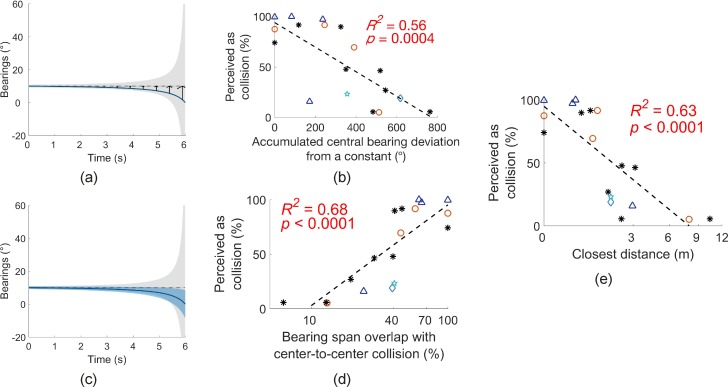
Visual cues for possible collision with an approaching pedestrian and their relationships with the collision judgment by the subjects. (a) Accumulated bearing deviations of pedestrian's central bearing from a constant bearing. The straight dashed gray line shows the constant central bearing representing the bearing of a center-to-center colliding pedestrian. The gray area indicates the bearing span of that colliding pedestrian increasing as a function of time. The dark blue curve shows the central bearing of a pedestrian passing-in-front, which starts at the same initial bearing. The black vertical arrows are samples of the accumulated bearing deviations. (b) The accumulated bearing deviations show a negative correlation with the subjects' perceived collision. (c) The bearing span overlap of the dark blue pedestrian (from (a)) with the center-to-center colliding pedestrian. The percent of overlap was calculated as the blue-gray overlapping area divided by the gray area. (d) The subjects' collision judgment shows a positive correlation with the bearing span overlap. (e) The collision judgment is negatively correlated with the closest distance between the subject and pedestrian. Data in the scatterplots are from the NV condition (same colors and icons as in Fig. 7). Additional data (black asterisks) are from (Qiu C, et al. IOVS. 2017;58:ARVO E-Abstract 3287).